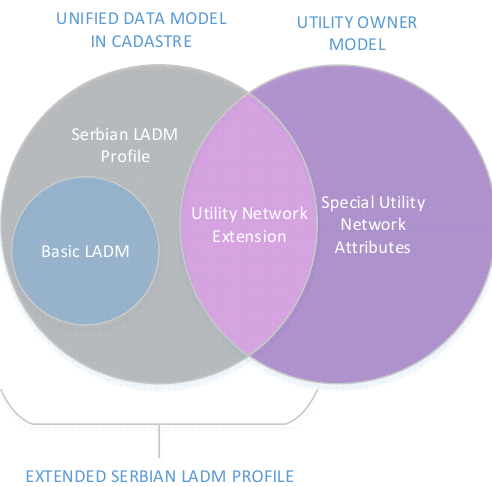
Figure 3. Venn diagram of the class and attribute disposition between models.